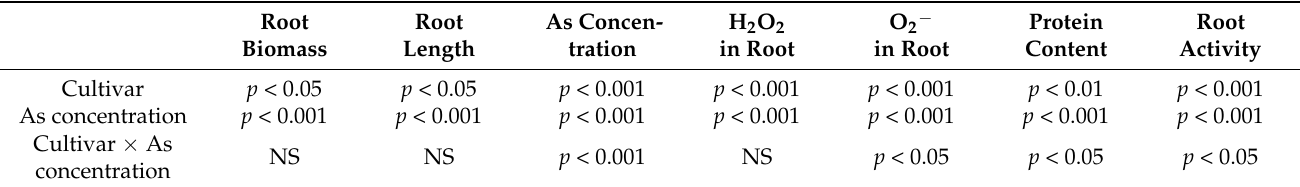
Table 3. Two-way ANOVA for the growth and physiological